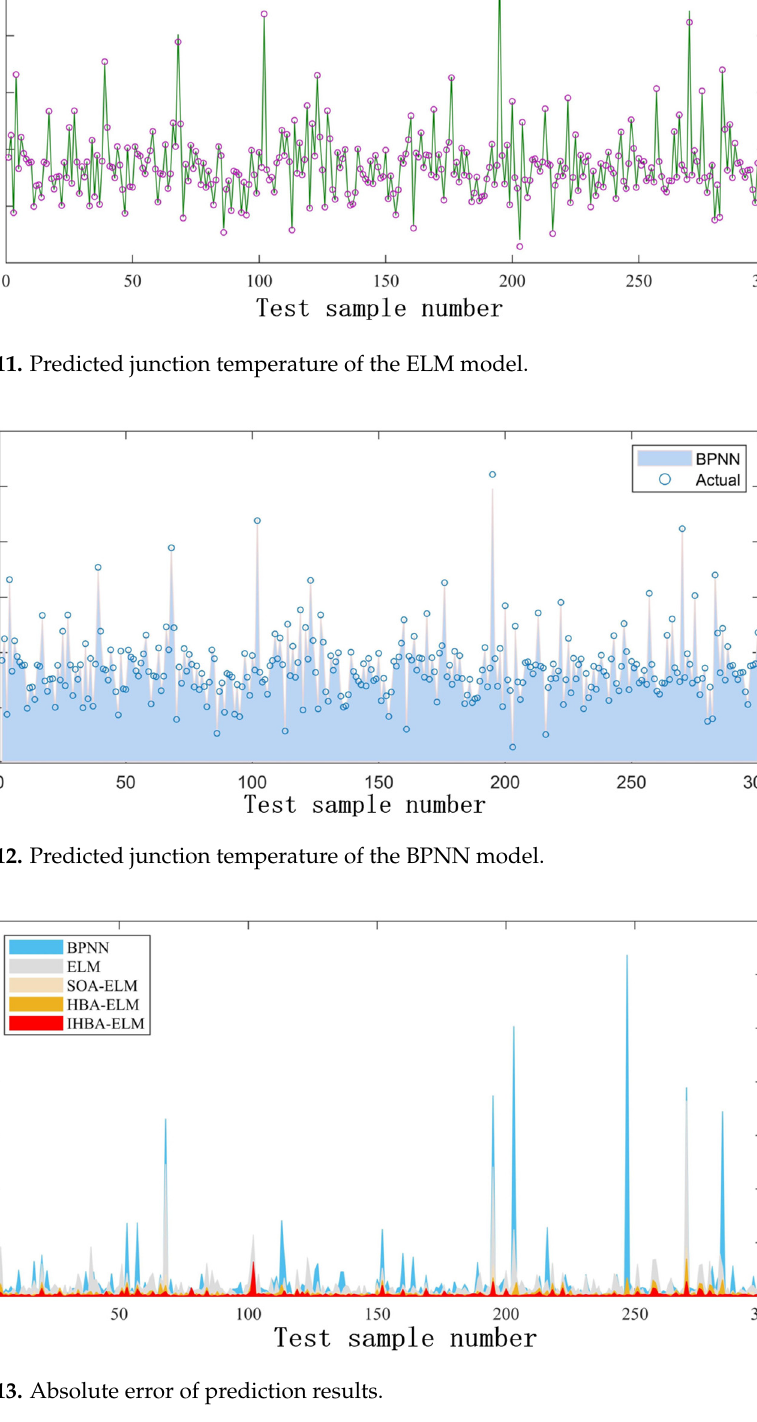
Figure 13. Absolute error of prediction results.